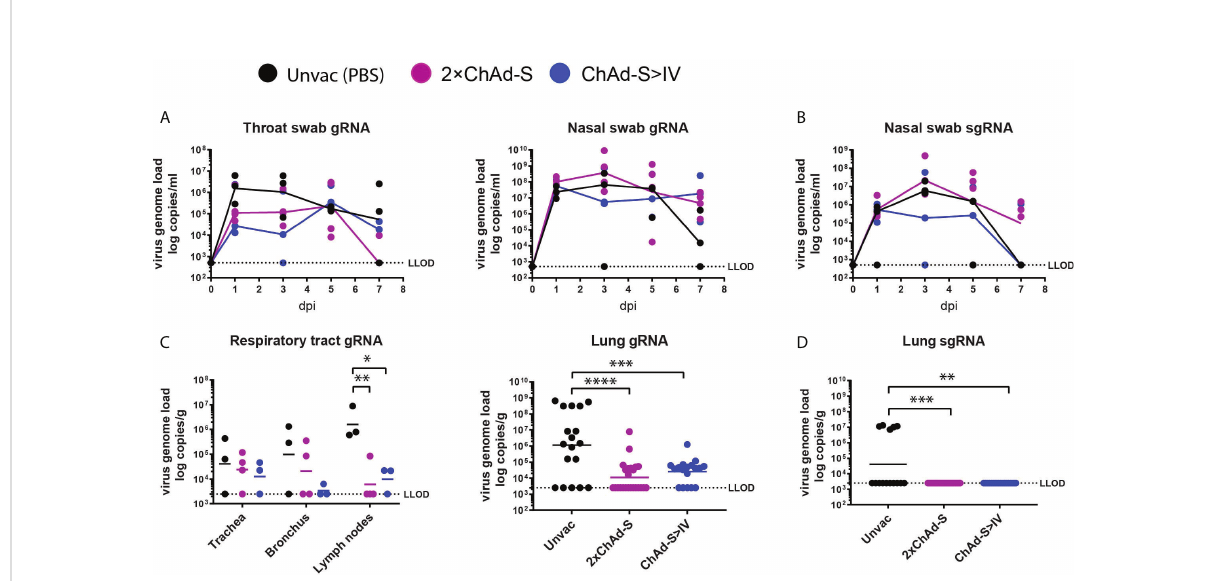
FIGURE 3 Viral load in NHPs after challenge by Beta variant. Throat swabs, nasal swabs, trachea, bronchus, lung lymph nodes, and lung lobe specimens were collected at the time shown in Figure 1A. (A – D) SARS-CoV-2 gRNA and sgRNA levels were measured by RT-PCR and expressed as viral copies. LLOD was the low limit of detection. gRNA was quanti fi ed in throat swabs (left panel) and nasal swabs (right panel) (A) , trachea, bronchus, lung lymph nodes (left panel) and six lung lobes (right panel, one spot represent one lung lobe out of six lobes for each animal) (C) . sgRNA was quanti fi ed in nasal swabs (B) and six lung lobes (D) . One spot represents one animal. One-way ANOVA was performed (C, D) *p<0.05, **p<0.01, ***p<0.001,